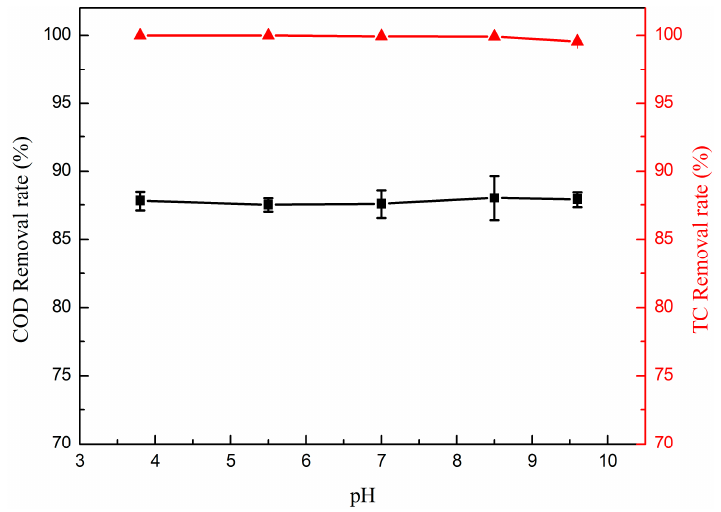
Figure 8. Effect of pH on the removal rate of TC ( ▲ ) and COD ( ■ ). ( TC = 50 mg·L − 1 , RT = 4.4 min, T = 25 °C, and j = 1 mA·cm − 2 ).